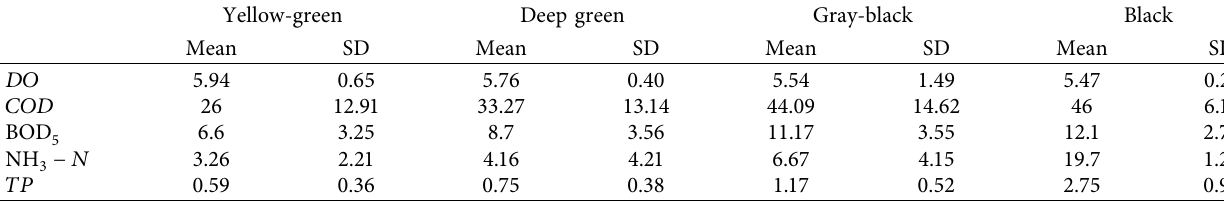
Table 1: Mean and standard deviation of the color model.